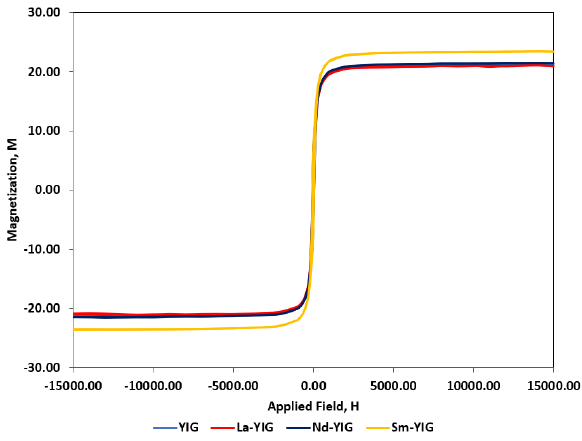
Figure 3. Magnetic hysteresis loop of RE-YIG nanoparticles.